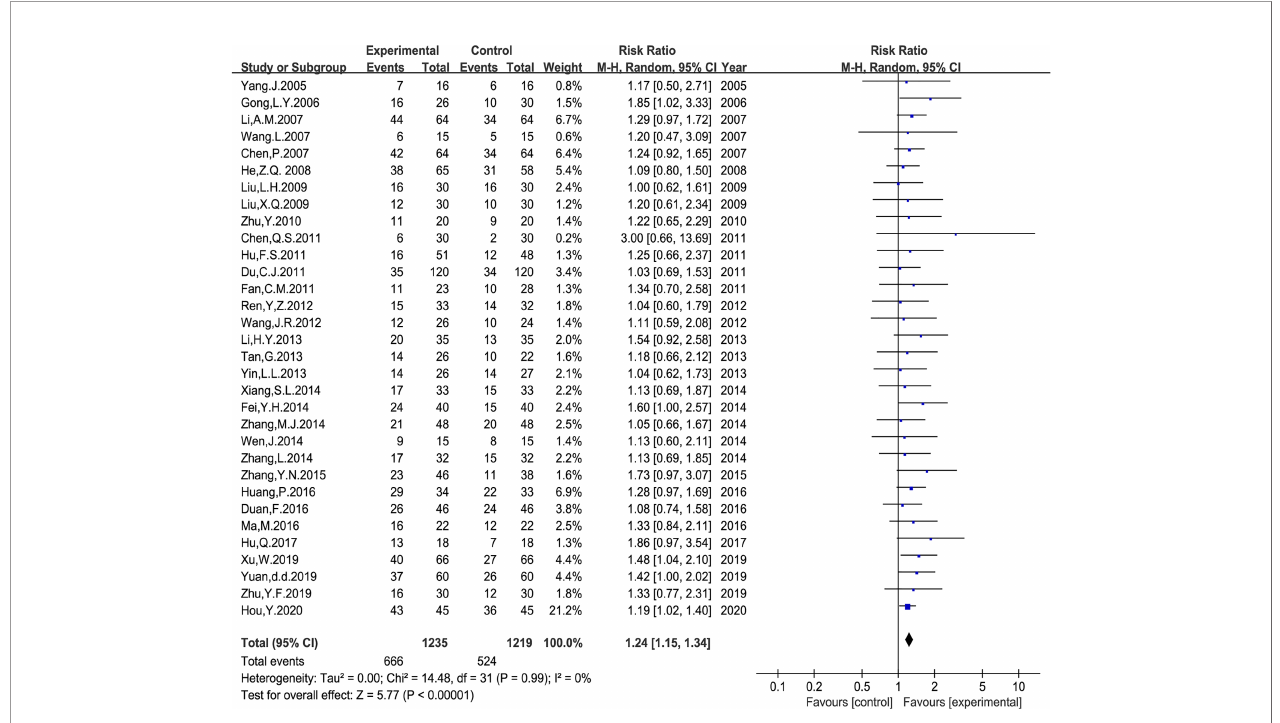
FIGURE 3 | Meta-analysis results of objective response rate (ORR) between the two groups.